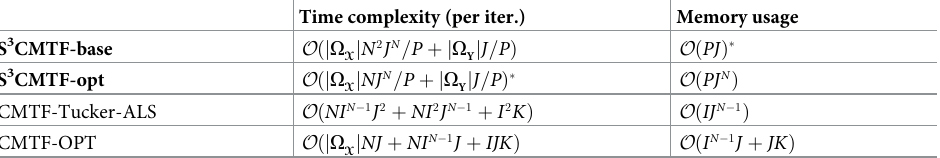
Table 3. Comparison of time complexity (per iteration) and memory usage of our proposed S 3 CMTF and other CMTF algorithms. S 3 CMTF-opt shows the lowest time complexity and S 3 CMTF-base shows the lowest memory usage. For simplicity, we assume that all modes are of size I , of rank J , and an I × K matrix is coupled to one mode. P is the number of parallel cores. ( � indicates the lowest time or memory). Time complexity (per